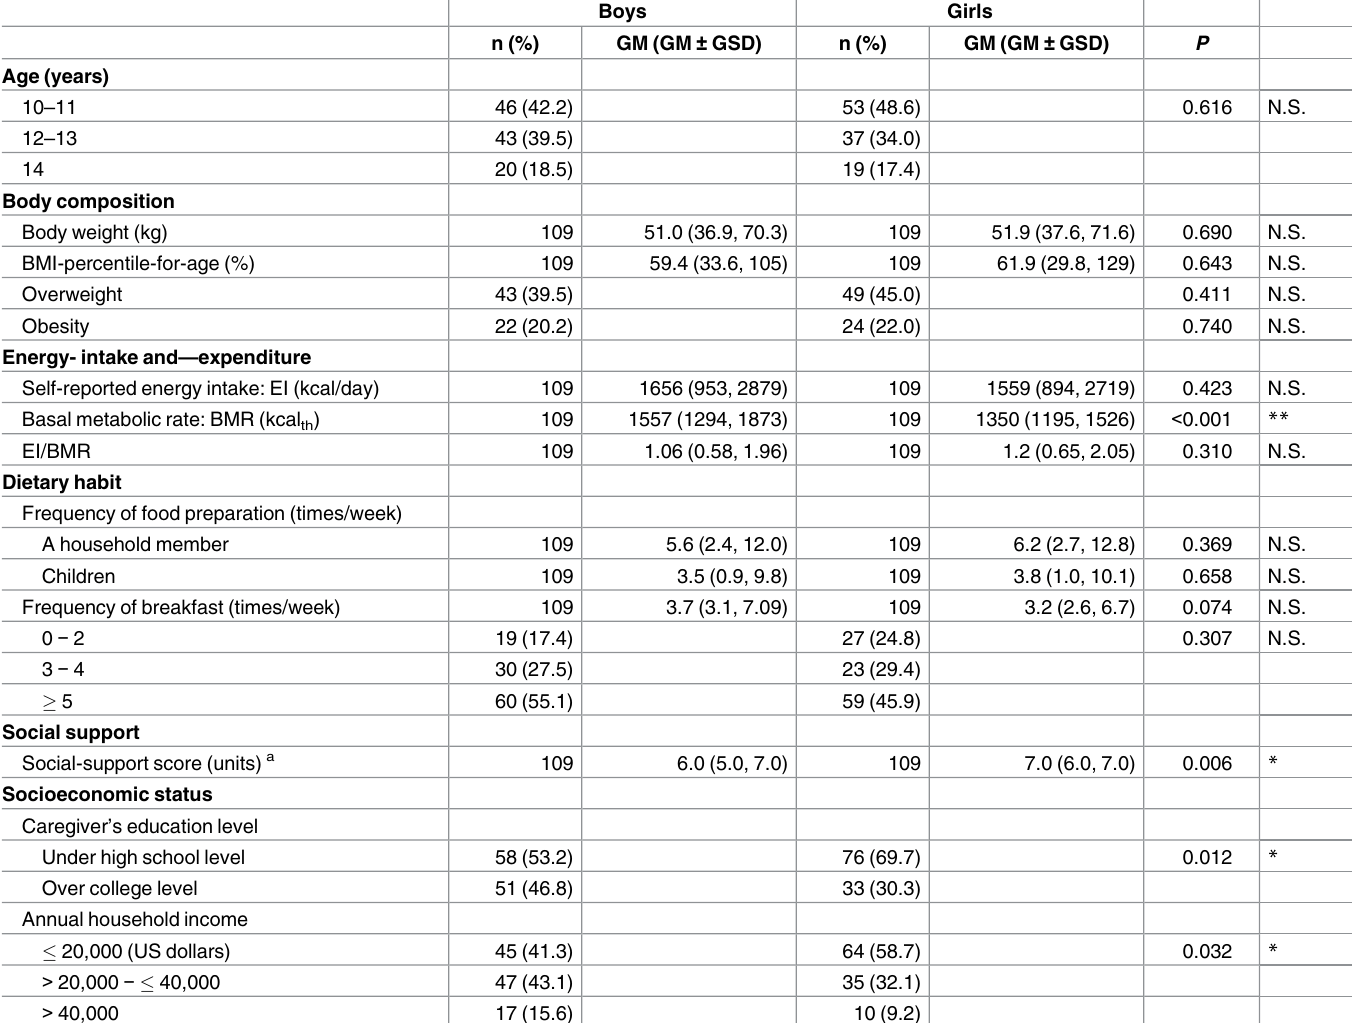
Table 1. Sex Differencesin the Baseline Demographics of the Study